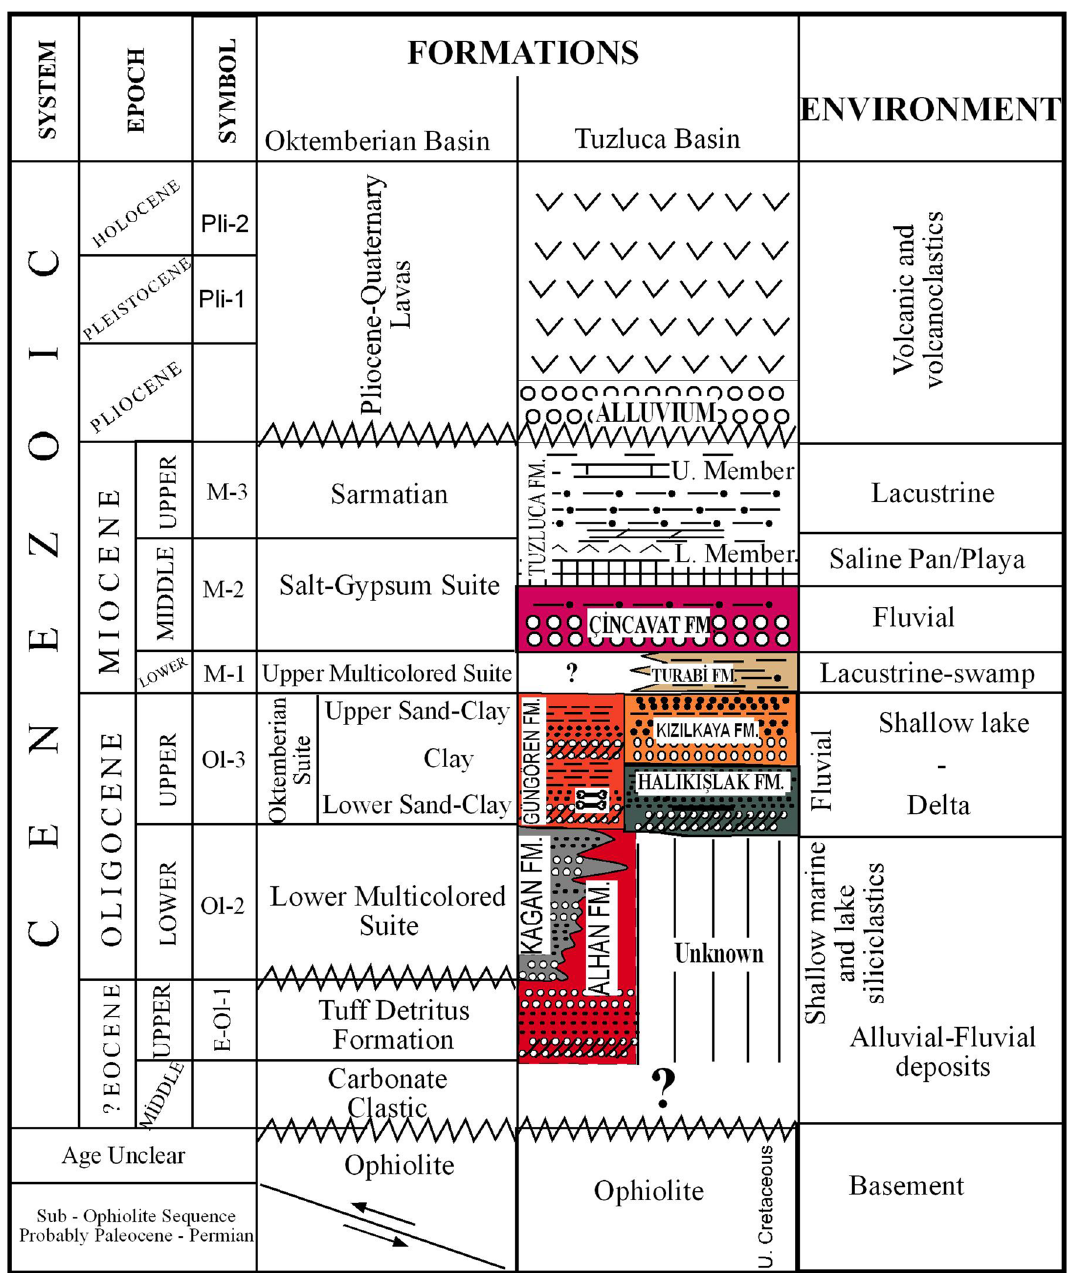
Fig. 3 Comparative stratigraphic columnar section of the studied area and Oktemberian basin (modified from Papworth and Aghabalyan 2002a; Varol et al.